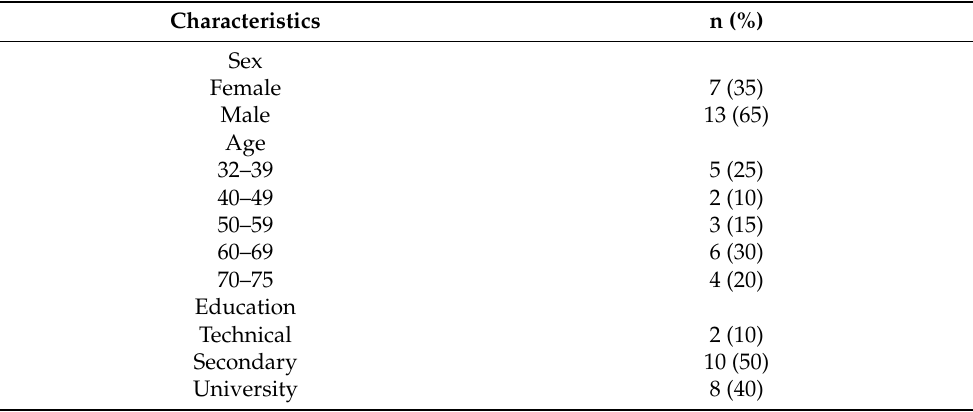
Table 1. Participants’ characteristics (n =